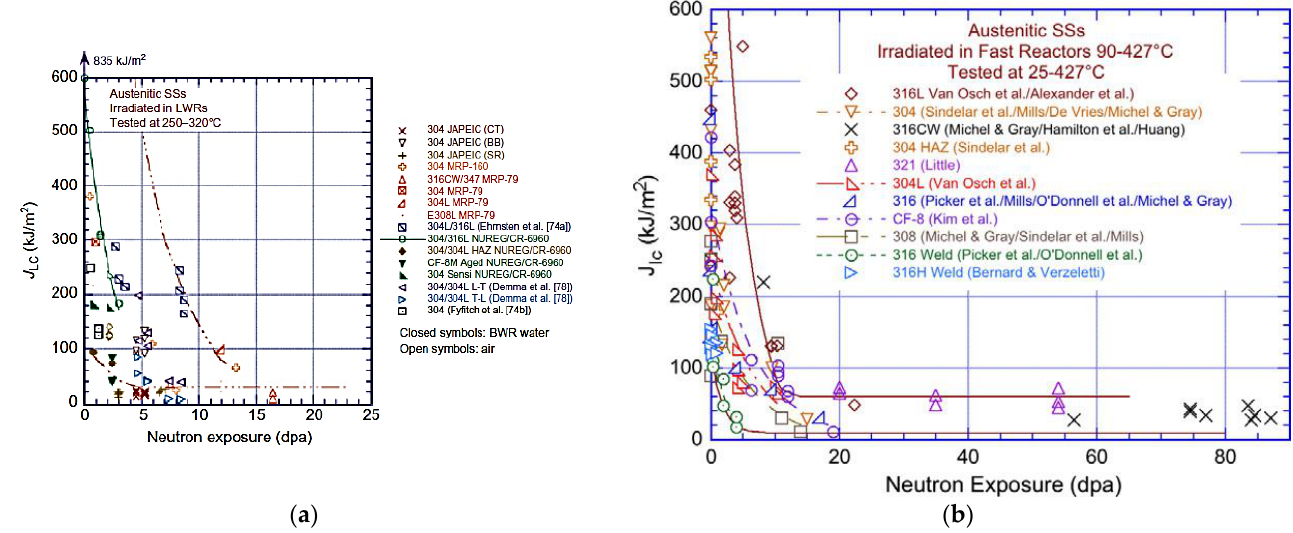
Figure 18. Fracture toughness as a function of neutron dose for austenitic alloys irradiated in: ( a ) fast reactors, 90 – 427 °C and tested in the temperature range 25 – 427 °C; ( b ) LWRs, irradiated at 288 – 316 °C and tested in the temperature range 250 – 320 °C. Reproduced with permission from [54].